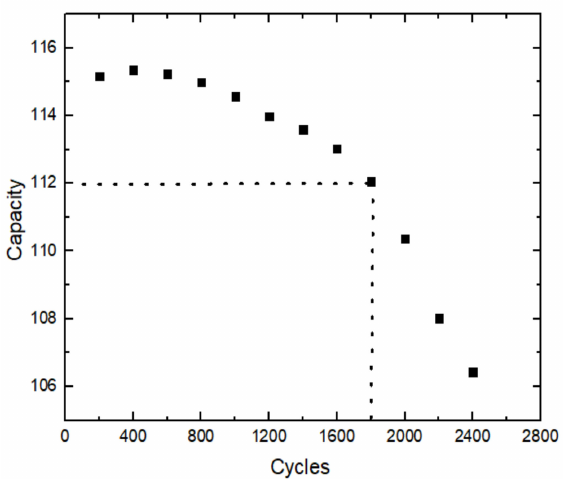
Figure 3. Li-ion battery capacity changes with the varies with the number of cycles.